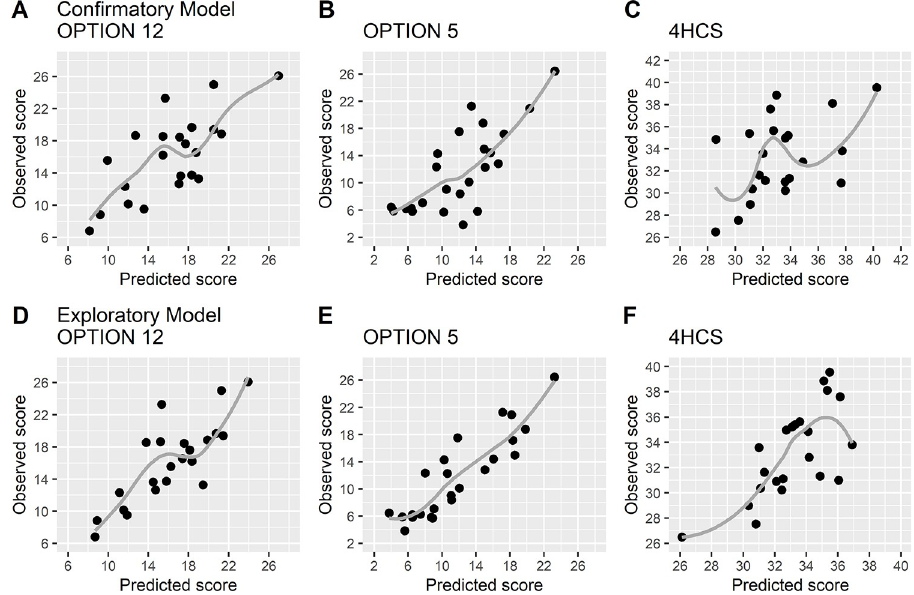
Fig 4. Calibration plots for the confirmatory and exploratory prediction of observer-rated SDM competence. Panels A, B and C show predicted and observed scores for the confirmatory model, panels D, E and F for the exploratory model. Black dots represent the physicians’ scores; smoothing (loess) curves are displayed for each outcome by the grey line. 4HCS, Four Habits Coding Scheme.